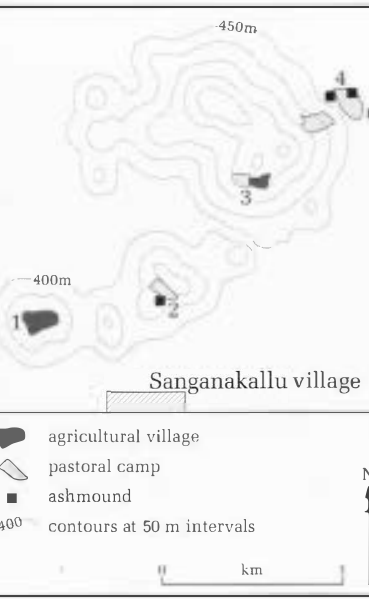
Figure 5 Distribution of